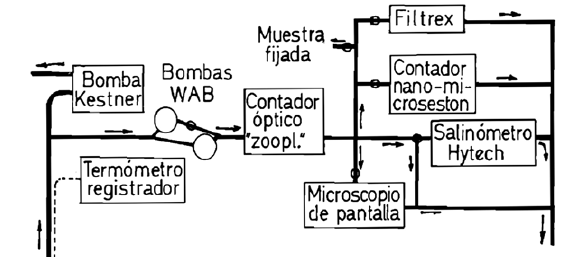
Fig. 12. – Schematic representation of the system for obtaining continuous, quasi-simultaneous data on marine physical, chemical and biological variables. It was used in the Belgian “Mediterranean Outflow” cruise on board the Mechelen . (Margalef 1967d).